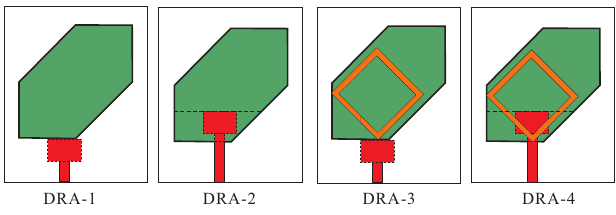
Figure 2. Configurations of DRA-1–DRA-4.